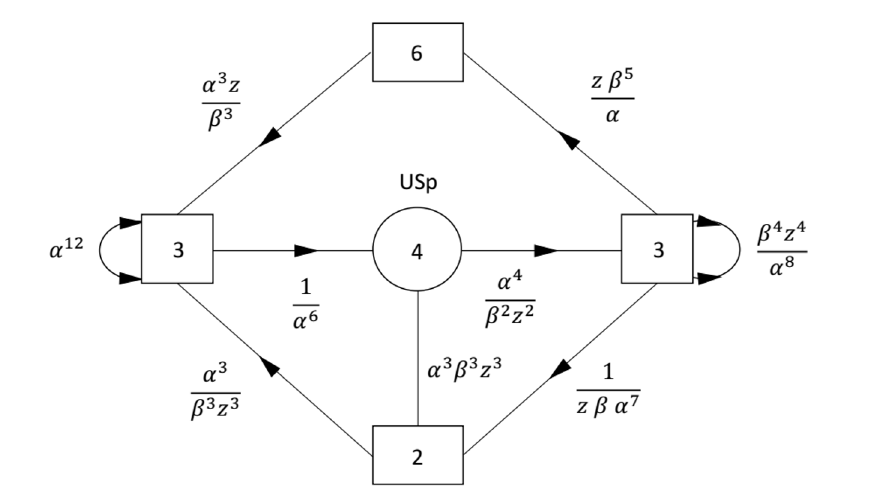
Figure 23 . The tube we get by gluing the tube in figure 22(a) with the one in figure 22(b). As usual, we have denoted the charges under the non-R symmetries using fugacities. The flux of this tube is equivalent to the one used to construct the (6 , 2) split model of section 4.2.1 and in fact the two tube models are actually IR